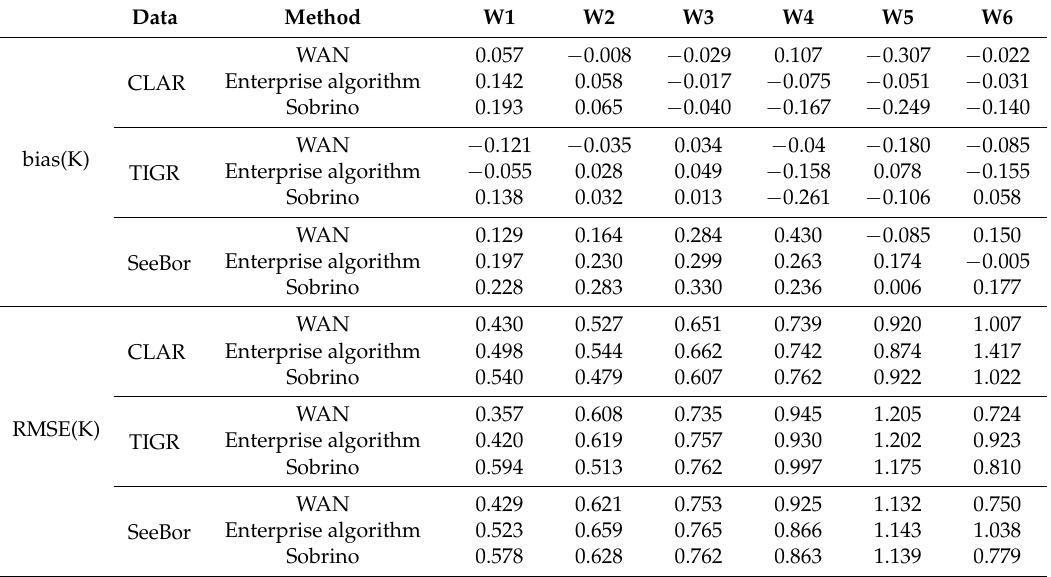
Table 3. The bias and RMSE of three split-window algorithms when tested by three independent atmospheric profiles. W1–W6 is the atmospheric water vapor range (W1 = 0.0–2.5 cm; W2 = 2.0–3.5